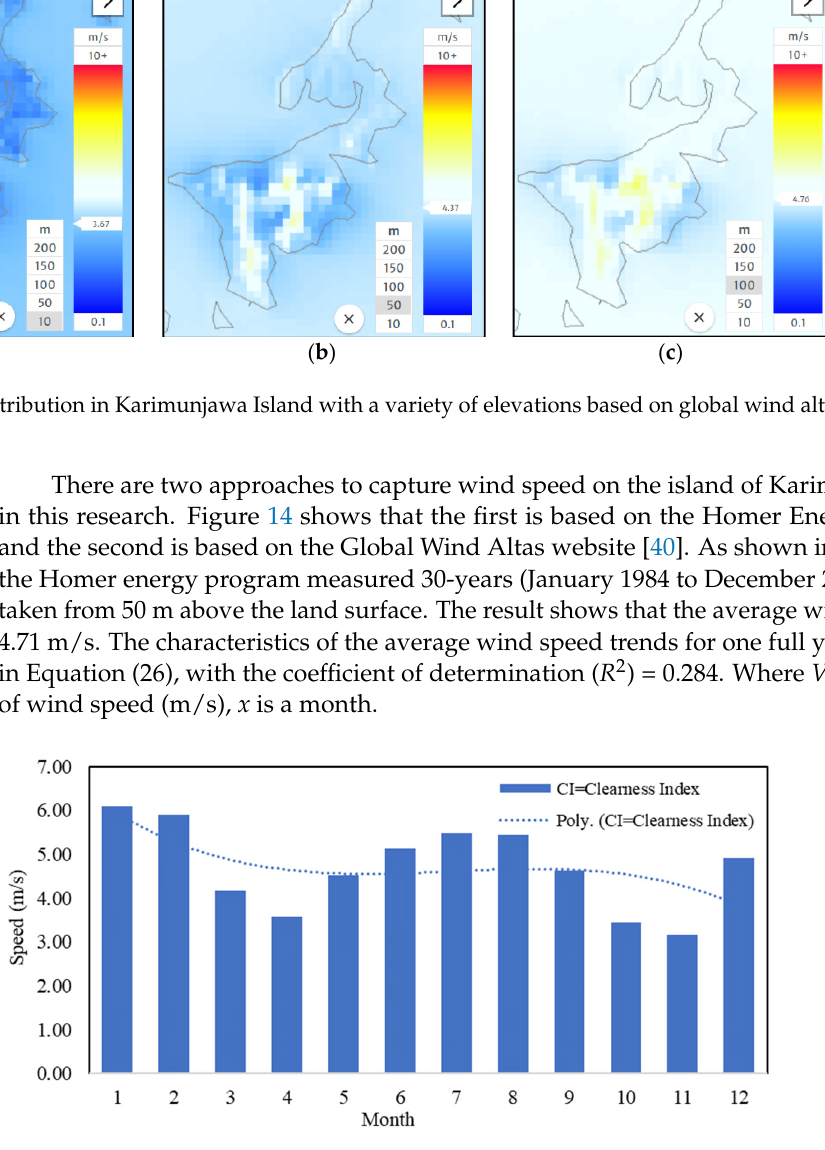
Figure 14. Rate monthly wind velocity in Karimunjawa Island form data base of Homer Energy.